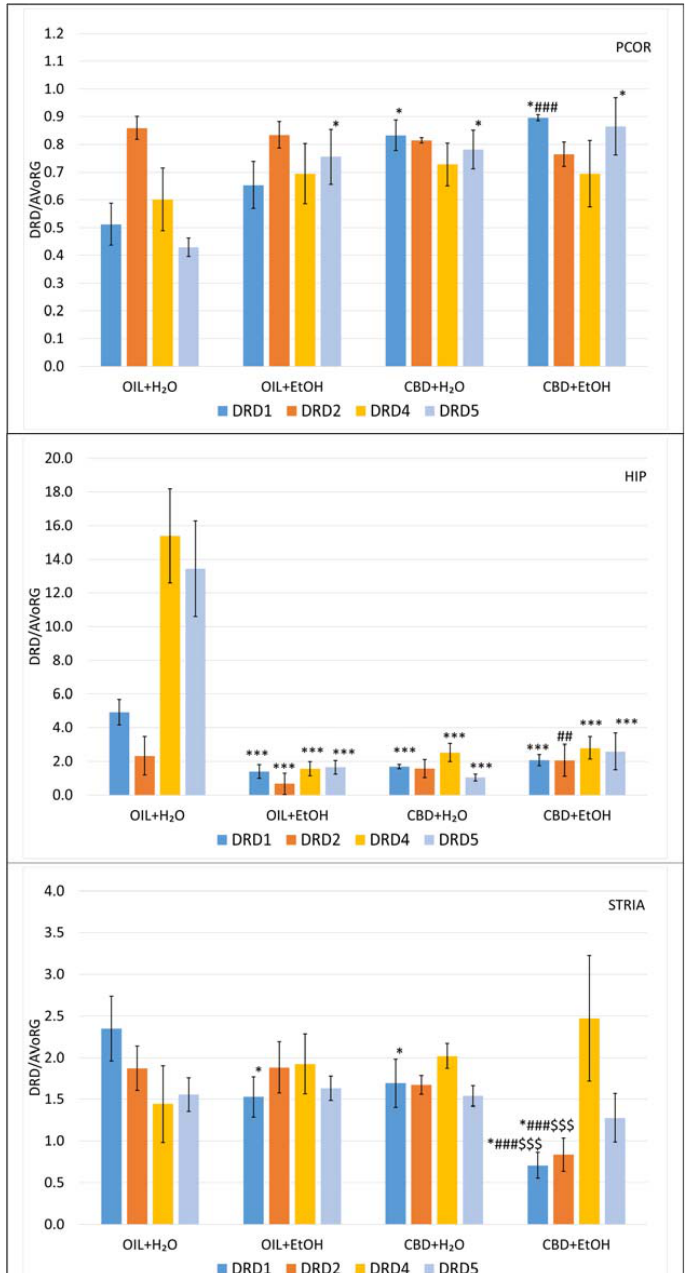
Figure 7. The effect of repeated once ‐ a ‐ day administration of CBD (cannabidiol; 20 mg/kg, p.o.) or